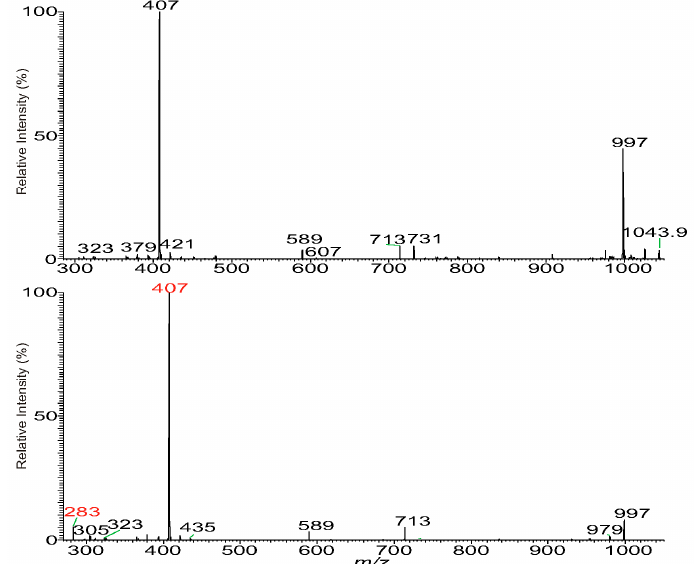
Figure 4. The negative-ion MS 2 spectrum of the [M + HCO 2 ] − ions of 18:0/27:1-DAT at m/z 1043 ( a ), its MS 3 spectrum of the ions of m/z 997 (1043 → 997) ( b ).